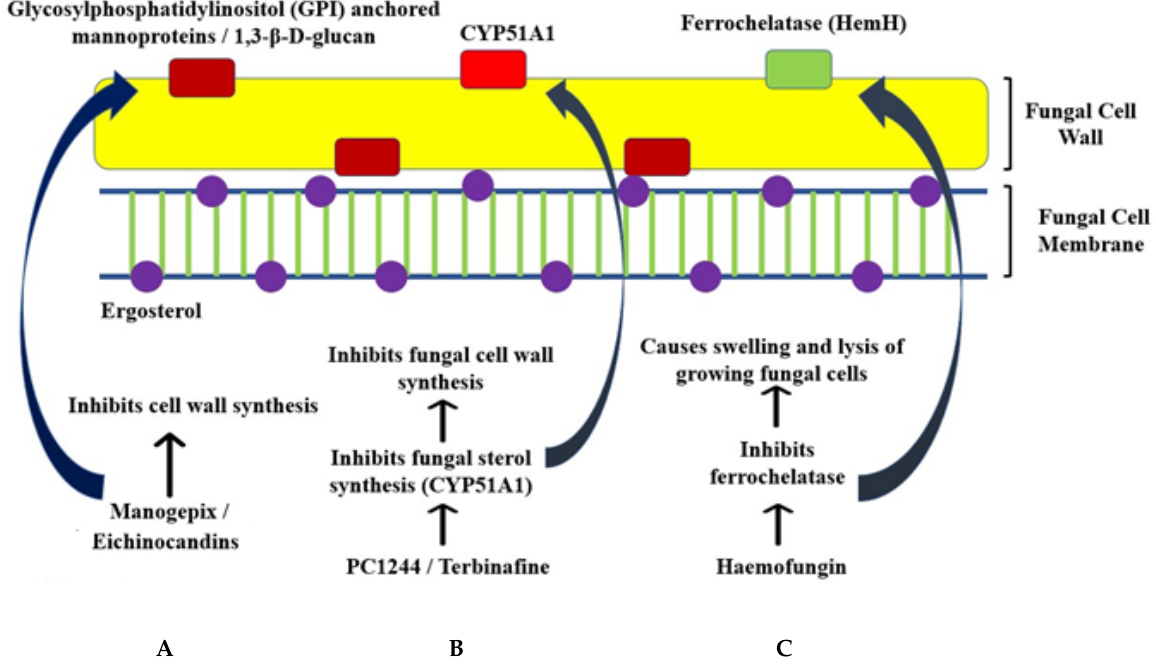
Figure 3. ( A ) Manogepix-mediated inhibition of mannoproteins. ( B ) PC1244-mediated inhibition CYP51A1. ( C ) Haemofungin-mediated inhibition of ferrochelatase. 8.1.3. Fosmanogepix (APX001) Fosmanogepix is the prodrug form of Manogepix. Systemic phosphatases convert it